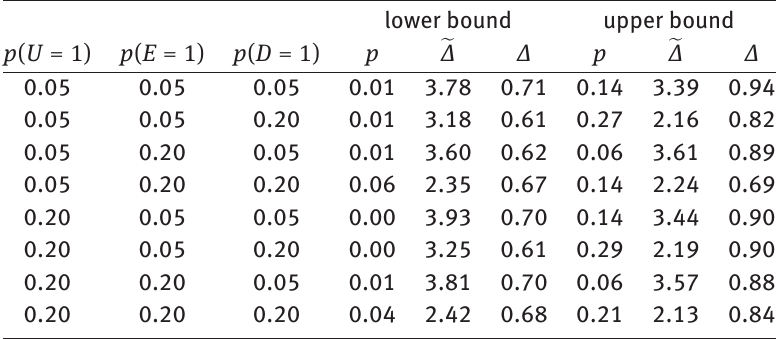
Table F4: Simulation results with σ = 3 . p is the proportion of times that the assumption-free bound was sharper than DV’s (cid:2) bound; Δ and Δ are the mean absolute distance between the log of the bound and the log of the true causal risk ratio, for DV’s bounds and the assumption-free bounds,